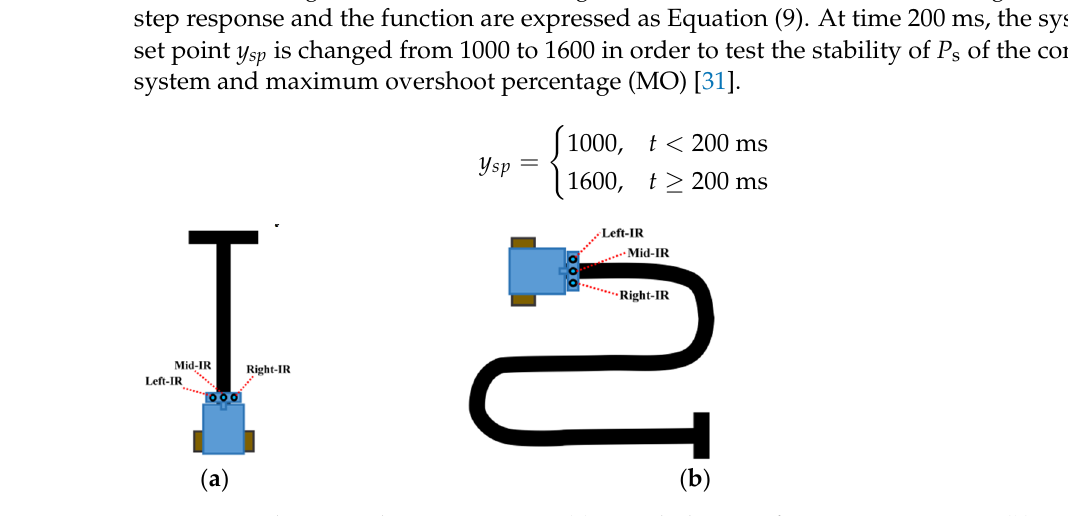
Figure 10. Output surface after defuzzification of fuzzy controller. ( a ) Δ k p Surface, ( b ) Δ k d Surface.